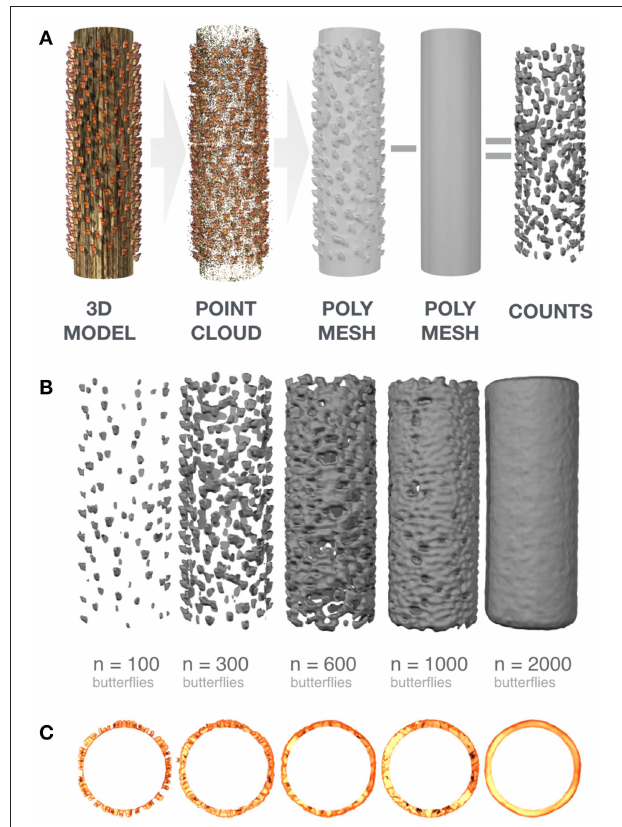
FIGURE 6 | Steps in the TLS/SVE analysis workflow using a modeled section of an Oyamel fir trunk. (A) The 3D model is surveyed via virtual photogrammetry to produce a point cloud which is then converted to a polygonal mesh; this represents the reference scan. A similarly derived polygonal mesh of the trunk without butterflies, the derivative scan, is subtracted from the reference scan so that the butterflies are separated from their roosting substrate. (B) Subtracted volumes of butterflies derived from simulated clusters of different sizes using a virtual application of the TLS/SVE workflow. The process allows the accurate calculation of correction factors specific to the photogrammetric survey of each cluster. (C) Cross-sections of the subtracted volume shapes for butterfly clusters of 100–2,000 individuals, indicating increasing density of the resulting